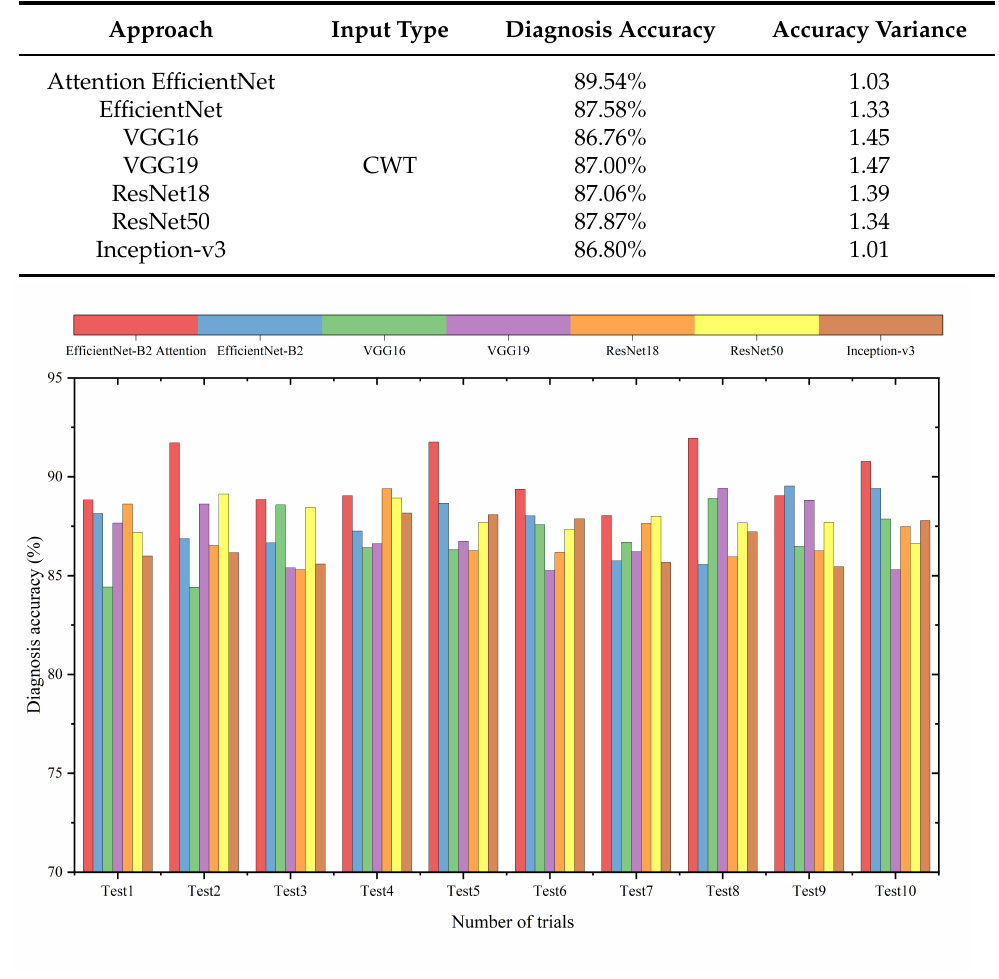
Figure 6. Detailed experimental results of different methods. Table 5. The diagnosis results under different pre-processing